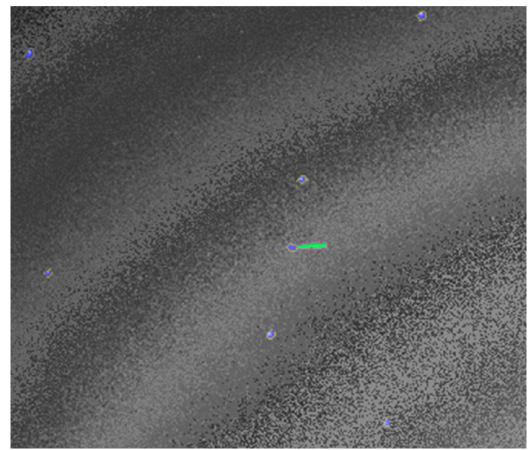
Figure 9. Objects classification: the streak candidate is shown in green, and the other large area objects in blue.